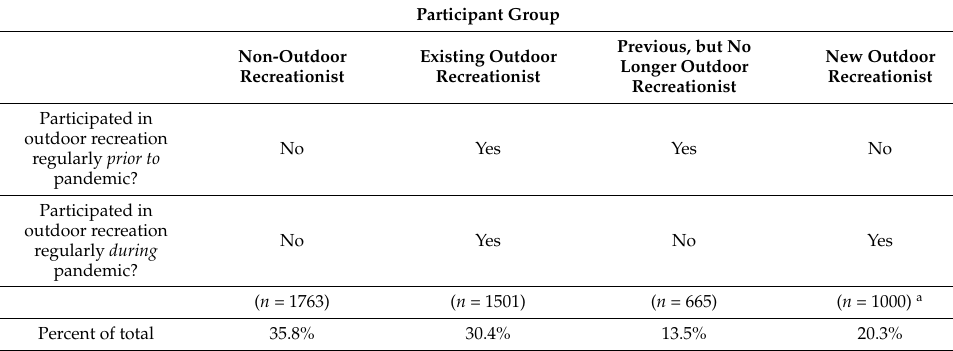
Table 2. Breakdown of non, existing, no longer, and new outdoor